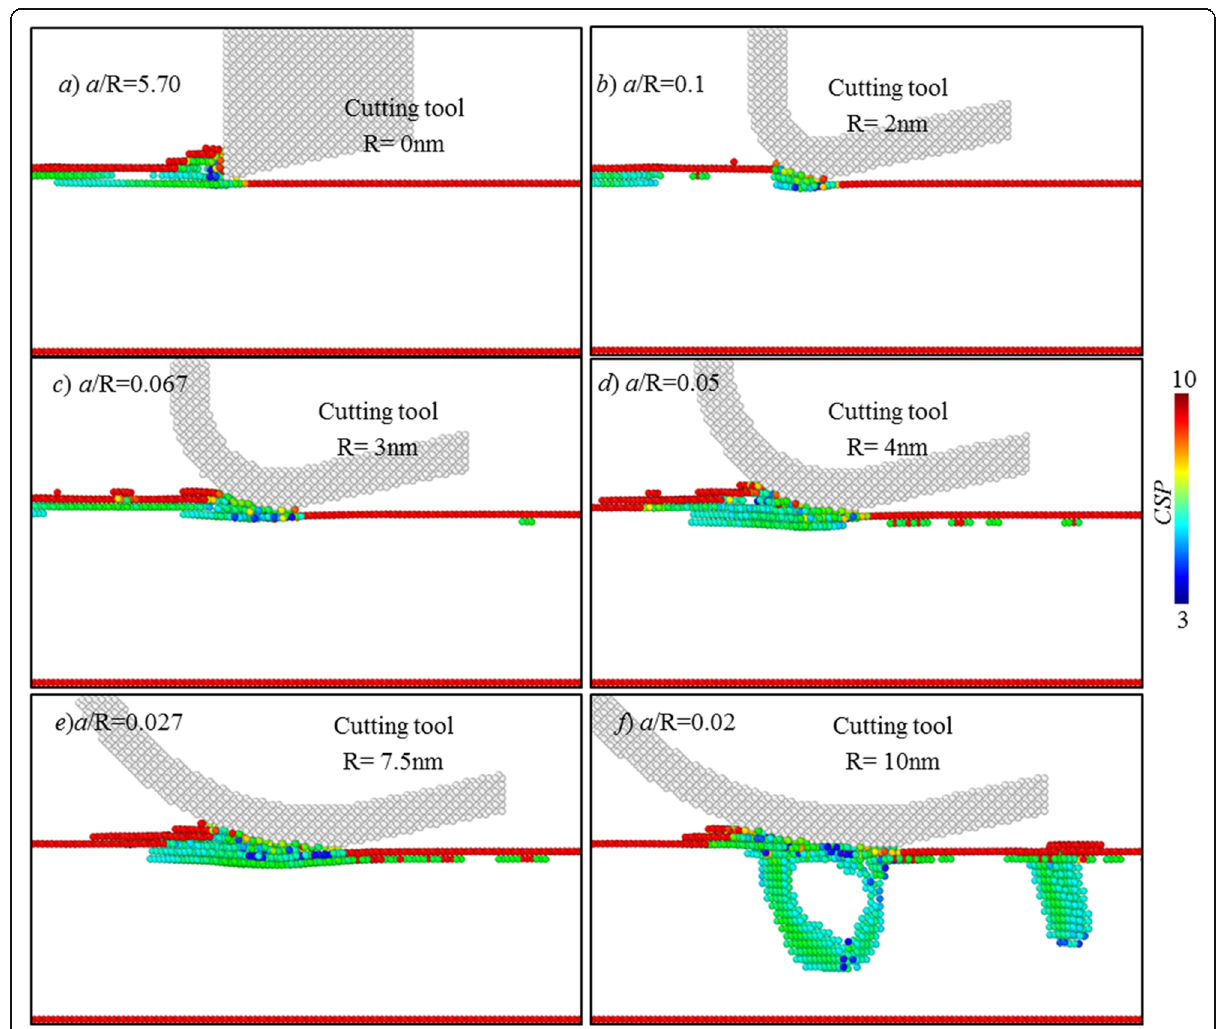
Fig. 8 Surface composition of the processed surfaces. Atoms are coloured based on their